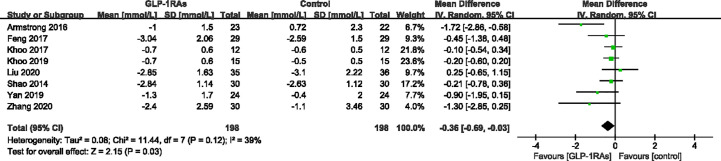
Mean difference or standard mean difference in change from baseline between glucagon-like peptide-1 receptor agonists (GLP-1RAs) vs. control. SD, Standard deviation; CI, confidence interval; IV, inverse variance; fasting blood-glucose (FBG, mmol/L).